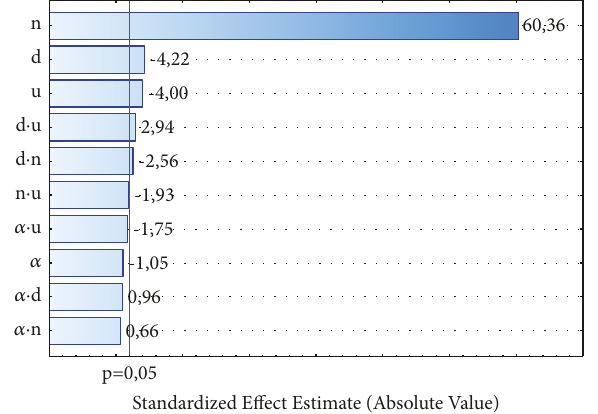
Figure 8: Pareto chart of standardised effects of the regression model of the polymer mass flow rate G.